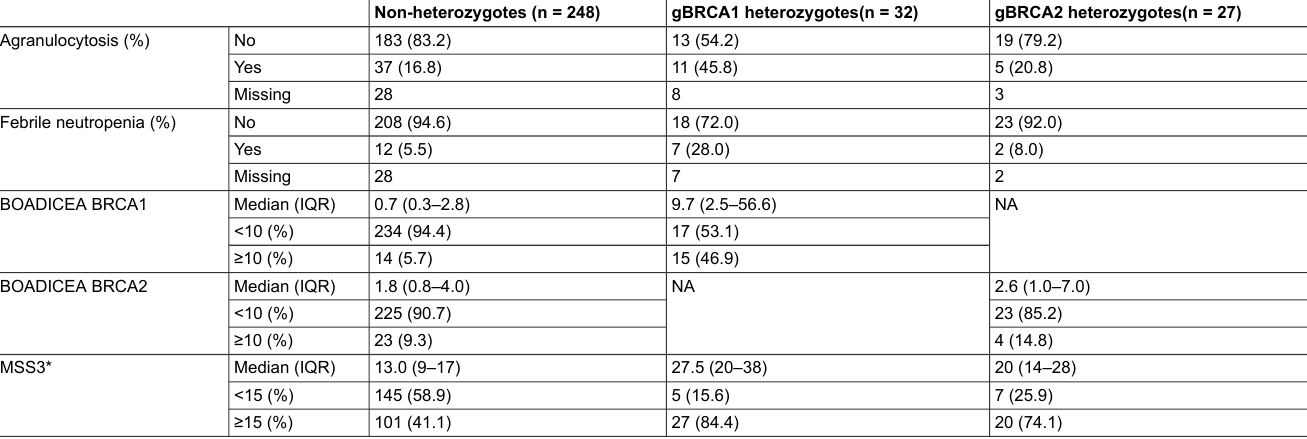
Non-heterozygotes (n = 248) gBRCA1 heterozygotes(n = 32)